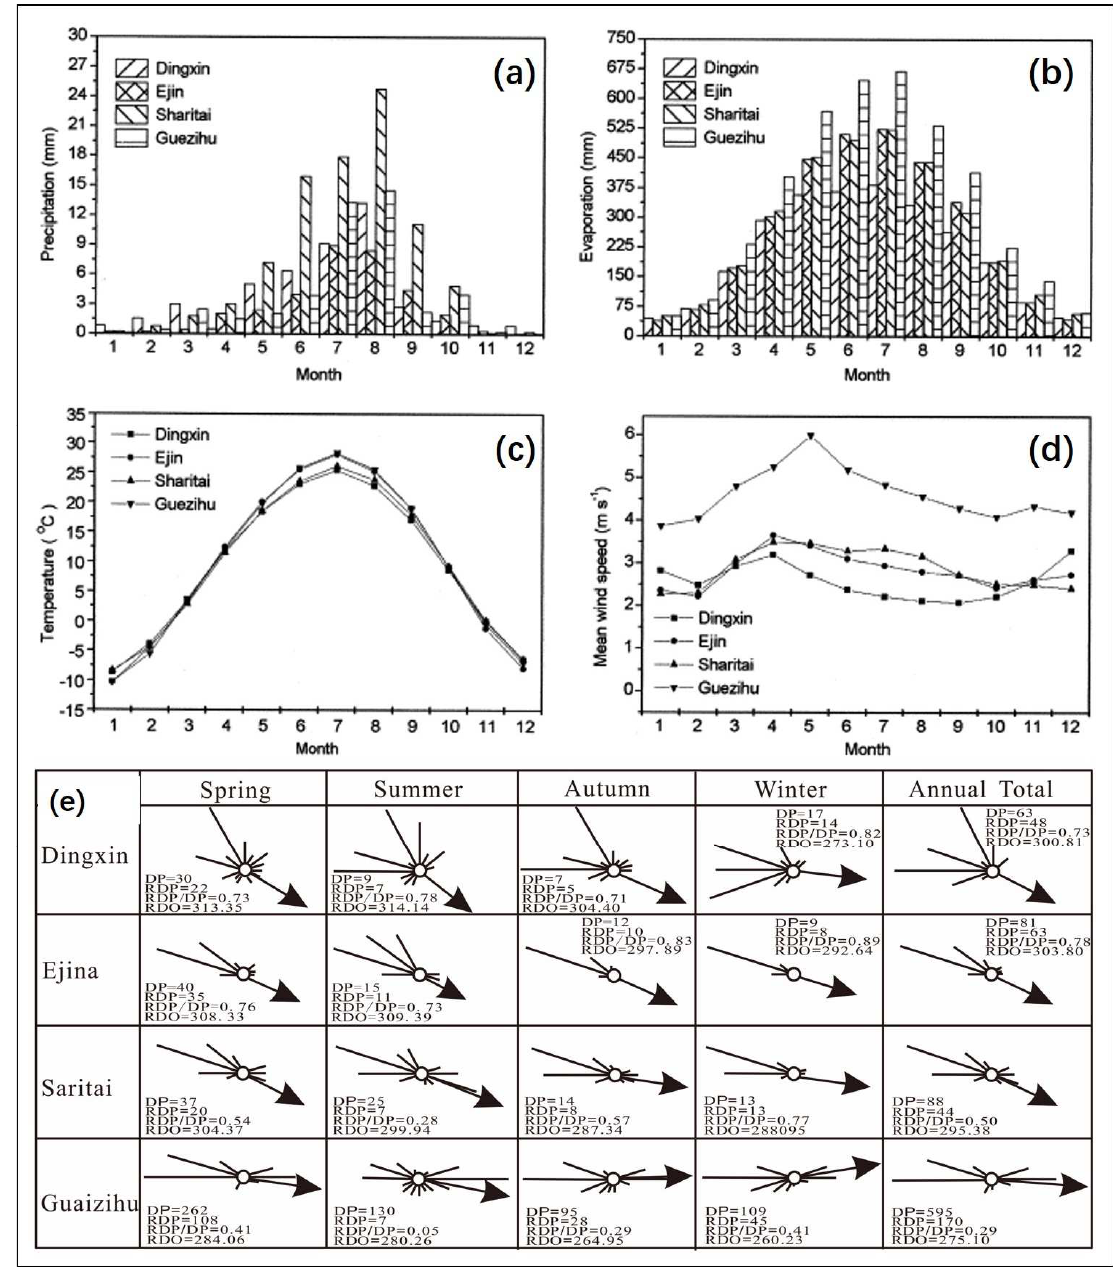
Figure 2. The climatic elements such as precipitation ( a ), evaporation ( b ), temperature ( c ), mean wind speed ( d ), and the sand drift potential (SDP) ( e ) in the different areas of the Badanjilin Desert (revised from [11]). DP, sand drift potential; RDP, resultant drift potentials; RDP/DP, directional factor; RDD, resultant drift direction. The background values of these modern climate parameters provide a necessary contrast for understanding the palaeo-environment of the Alashan Plateau.